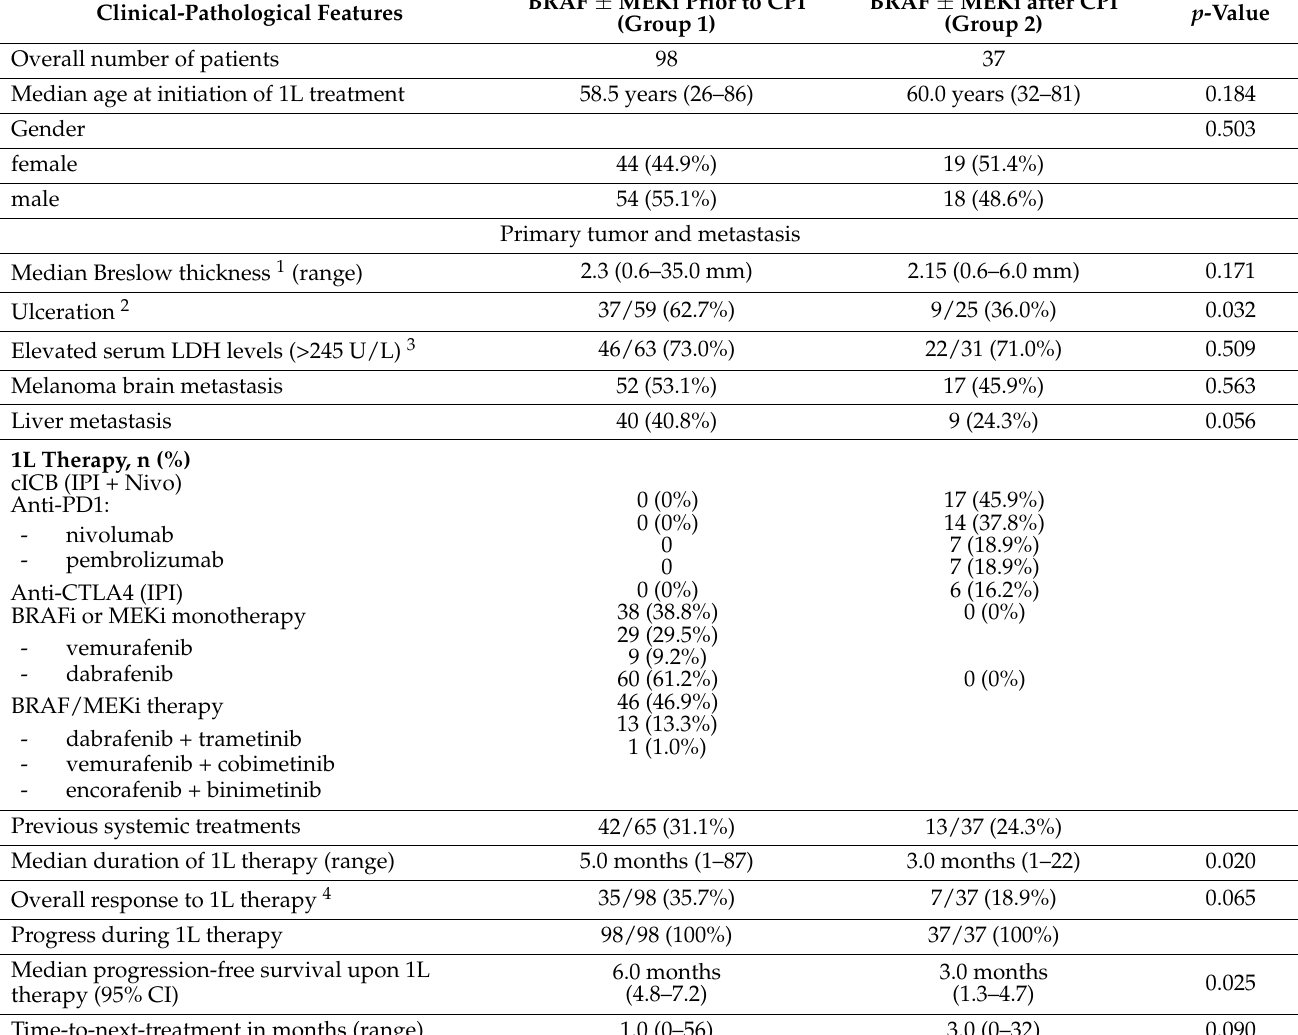
Table 1. Baseline patient characteristics and treatment